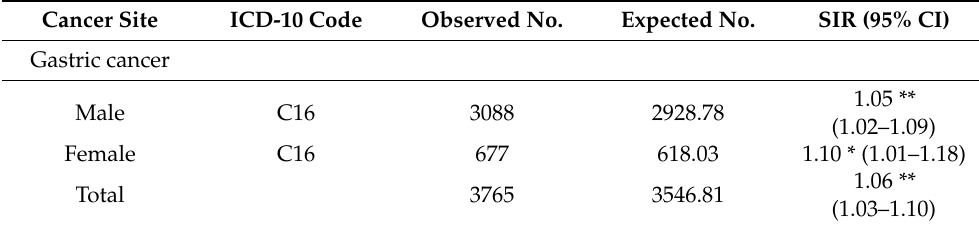
Table 1. Standardized incidence ratio (SIR) of gastric cancer among the occupational cohort of worker exposed to asbestos, using the general population of Taiwan as reference.